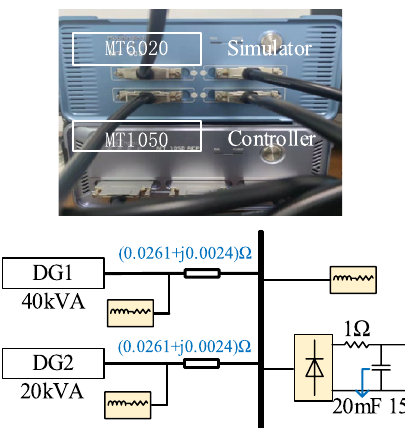
Fig. 22 The test circuit of hardware-in-the-loop experiments